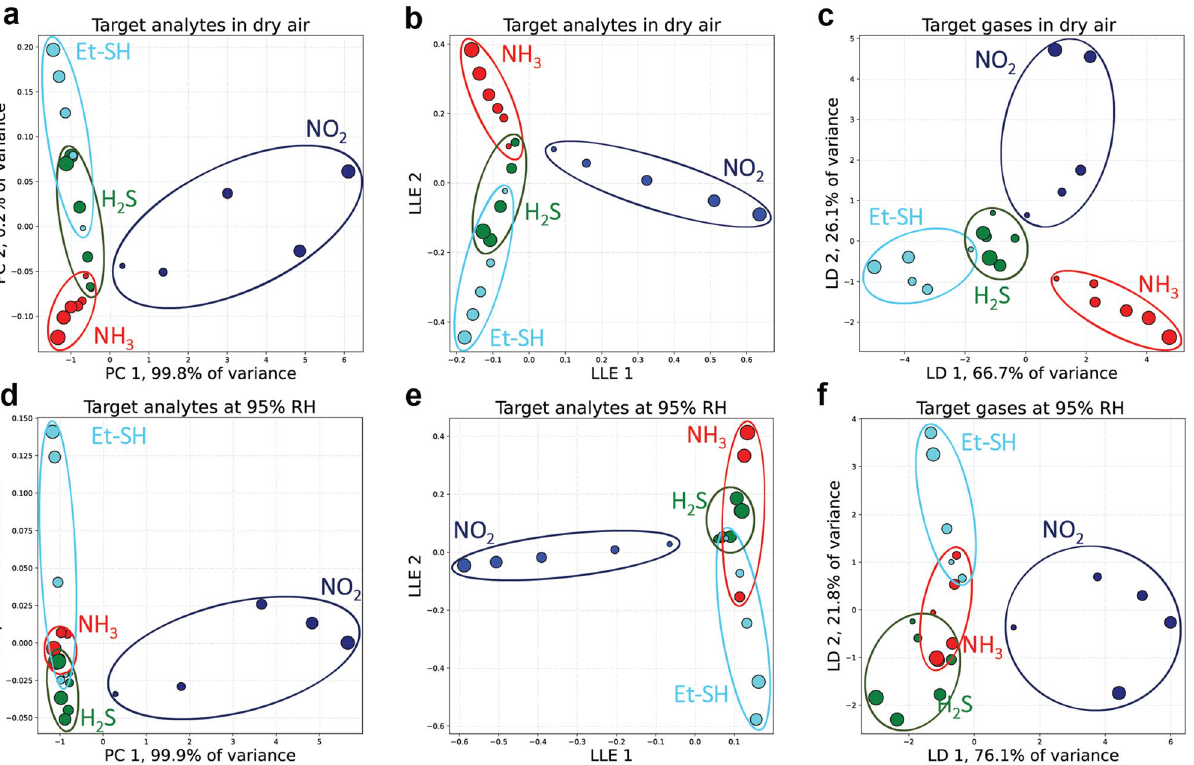
Figure 4. Sensor array discriminative abilities demonstration with dimensionality reduction algorithms in dry (top row) and humid (bottom row) air. ( a , d ) Principal Components Analysis (PCA). ( b , e ) Local Linear Embedding (LLE). ( c , f ) Linear Discriminant Analysis (LDA). Dot size corresponds to the concentration (not in scale; NH 3 and H 2 S are presented at 100, 200, 500, 800, 1000, 1500 ppb, NO 2 at 100, 200, 500, 800, 1000 ppb and Et-SH at 40, 80, 120, 160, 200 ppb concentrations). Dotted color ellipses include all the measurements related to a specific gas and border regions on the